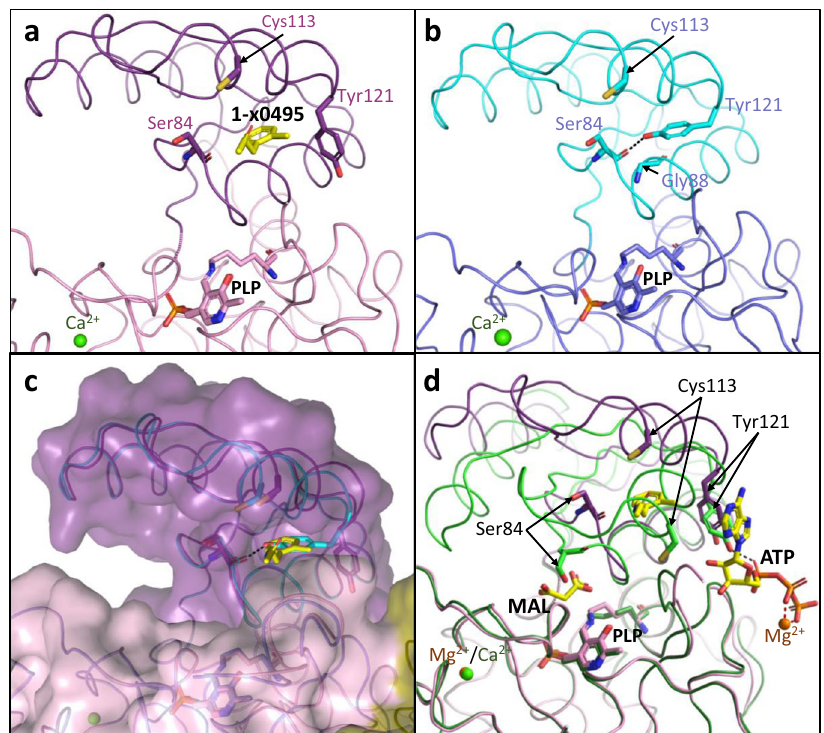
Fig. 3 XChem compound 1-x0495 can displace tyrosine 121. a View of subunit A from 1.53 Å human SR structure with compound 1 -x0495 from an XChem fragment screen (pdb code: 7NBG). Overall structure is shown as a C α ribbon with stick representations of Ser 84 and the side-chains of Tyr 121 and Cys 113 (purple carbons). The PLP covalently attached to Lys 56 is also shown (sticks, pink carbons). b Equivalent view of 1.8 Å holo /ligand-free SR structure (pdb code: 6ZUJ) with Ca 2 + ions (green sphere). The hydroxyl of Tyr 121 is within H-bonding distance of the main-chain carbonyl oxygen of Ser 84 (dotted line). c Superposition of the 1.53 Å structure with compound 1-x0495 (7NBG) with the 1.8 Å holo /ligand-free SR structure (6ZUJ). A semi- transparent surface has been drawn on 7NBG. d Large domain superposition of the 1.53 Å structure with compound 1-x0495 (7NBG; magenta ribbon) on the 1.6 Å malonate/ATP structure (6ZSP; green ribbon). Note Tyr 121 is in a similar position in both structures but Ser 84 and Cys 113 have